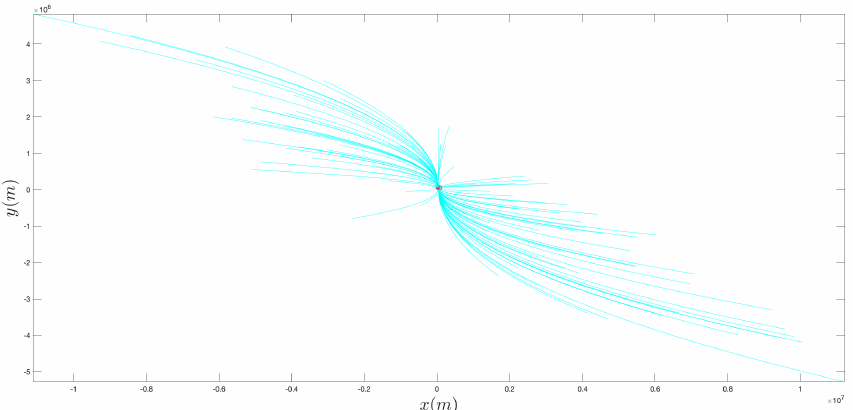
Figure 6. Sampling of 100 trajectories (cyan) based on the best solution found via the unconstrained, APF direction approach and on the CRLB covariance matrix.